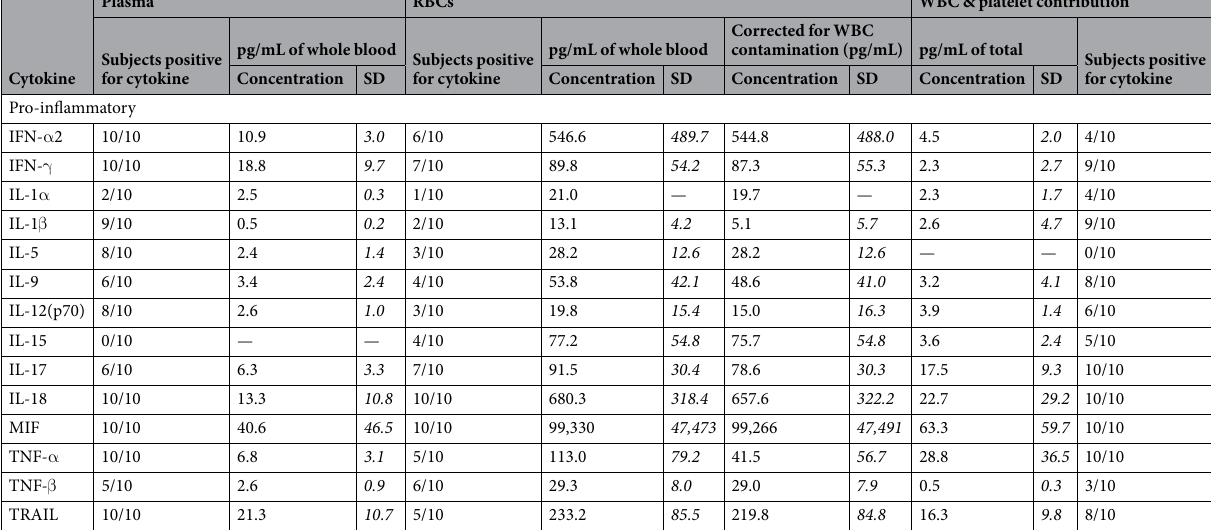
Table 1. Concentration of pro-inflammatory cytokines in EDTA plasma and RBCs in one millilitre of whole blood with correction for white blood cell (WBC) and platelet contamination ( n = 10), data are presented as mean ± SD.